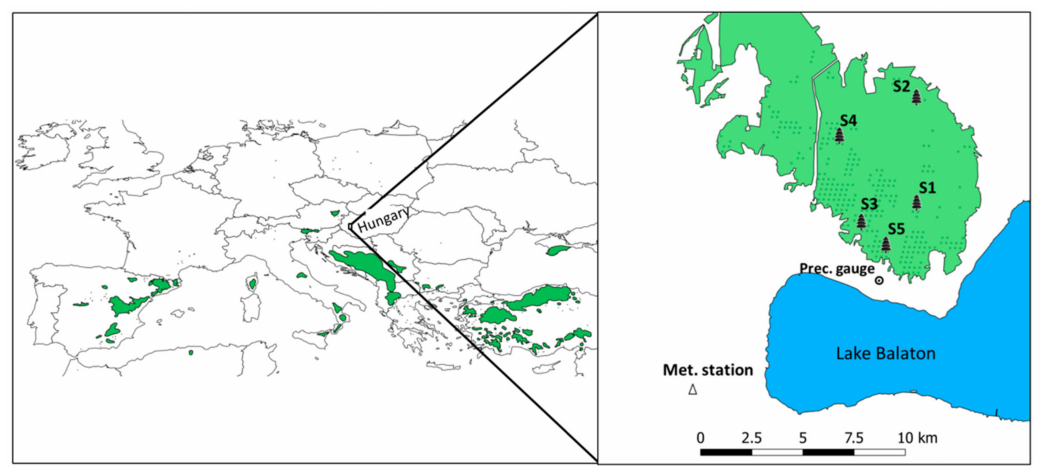
Figure 1. Distribution map of Black pine in Europe (green areas; source: EUFORGEN 2009 [30]) and location of the five study sites (S1–S5) in the Keszthely Mountains (within the green area denoting the forest area, the dots mark the subcompartments where the mixture ratio of Black pine was highest).